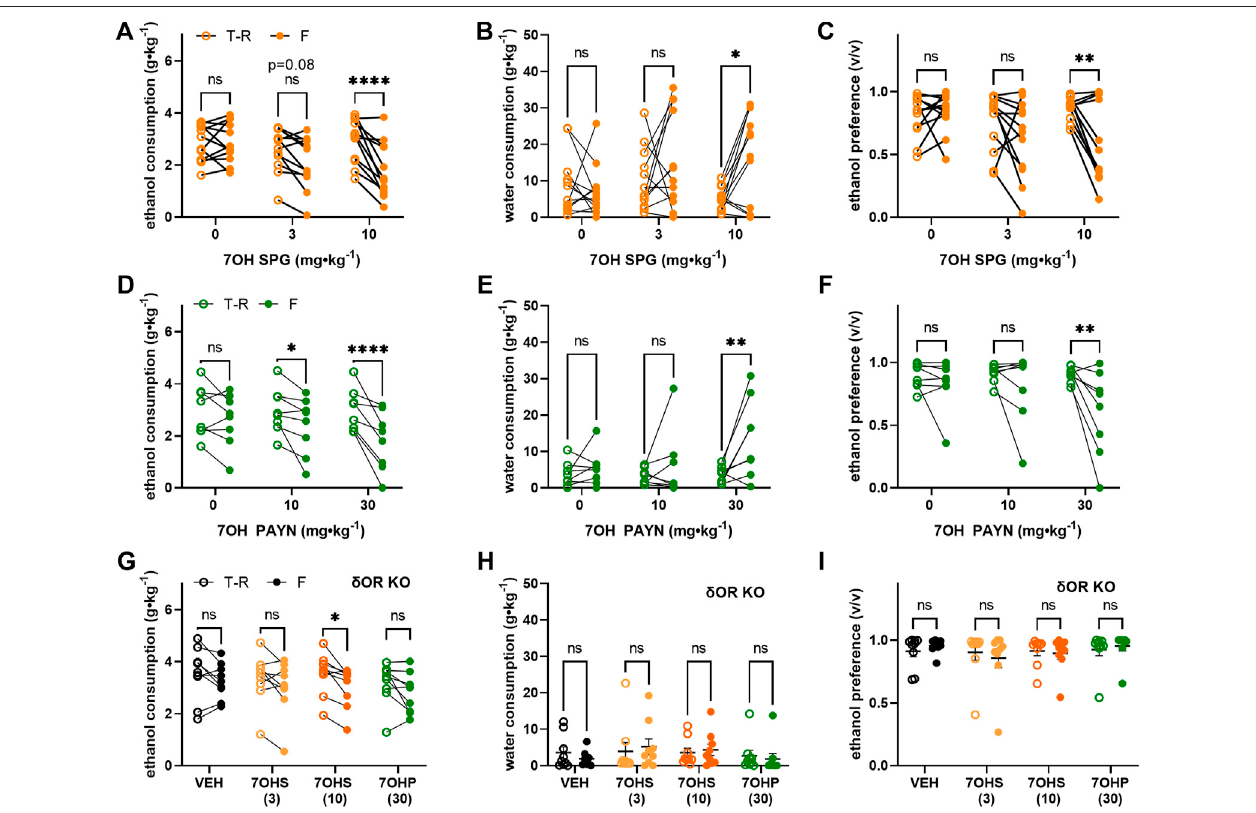
FIGURE 5 | Kratom analogs decrease voluntary ethanol consumption in mechanisms partially dependent on δ OR. 10% ethanol consumption (left column), water consumption (middle column), and ethanol preference (right column) in male C57Bl/6 wild-type mice following treatment with (A – C) 7-hydroxyspeciogynine (3 and 10 mg · kg − 1 , s.c., n (cid:2) 12, 7OH SPG; 7OHS), (D – F) 7-hydroxypaynantheine (10 and/or 30 mg · kg − 1 , s.c., n (cid:2) 8, 7OH PAYN; 7OHP), and in (G – I) male δ OR KO mice ( n (cid:2) 9), following treatment with effective doses of both analogs in a voluntary two-bottle choice, limited access, drinking-in-the-dark paradigm. Open circles are the average intake/preference on the preceding 3 days (baseline), and closed circles are the intake on Fridays following drug exposure. * p < 0.05, **p < 0.01, **** p < 0.0001 (for details, see Supplemental Tables S6 – S8 ).